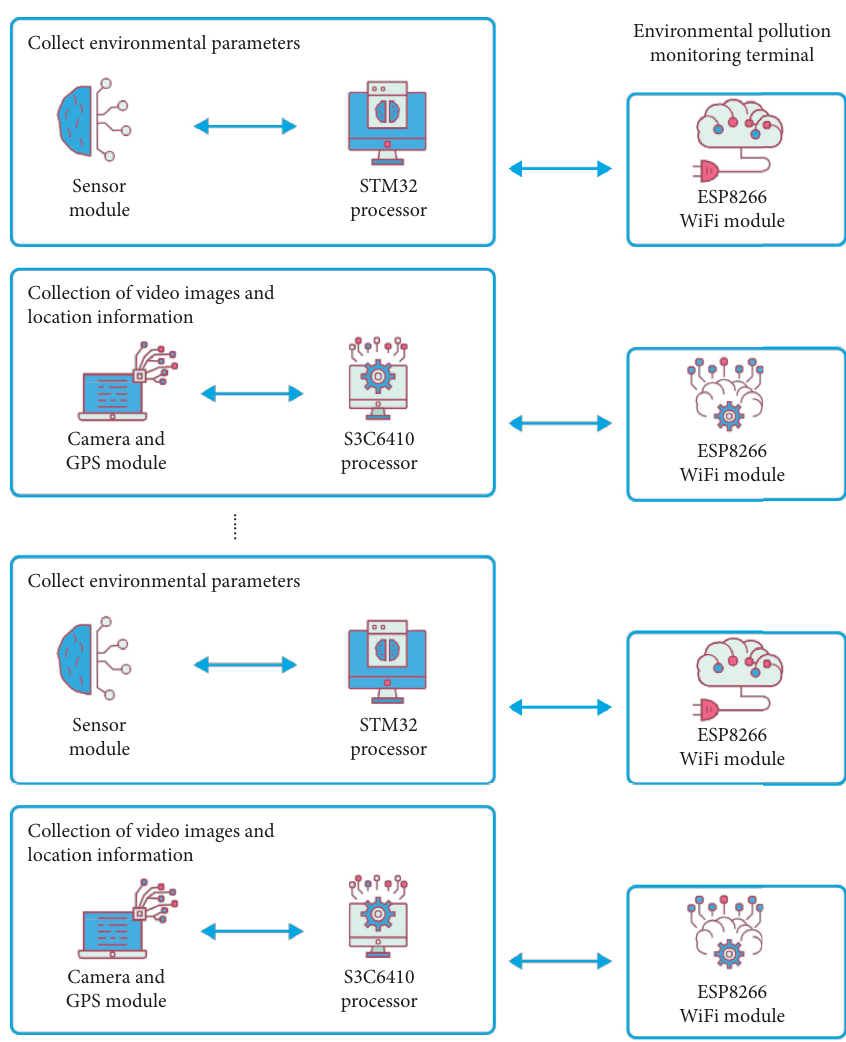
Figure 1: System function design